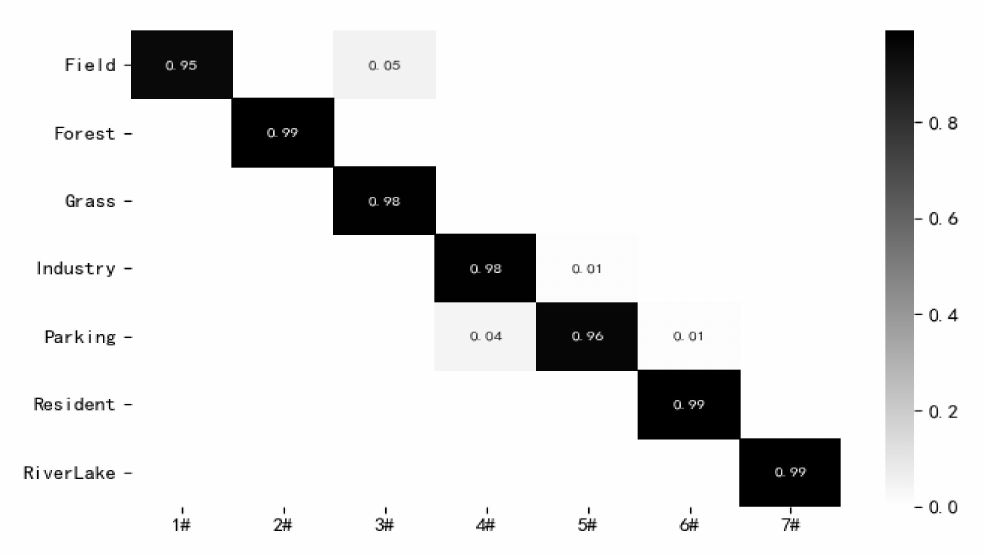
Figure 7. Confusion matrix of the LCNN-CMGF method on the RSSCN7 dataset